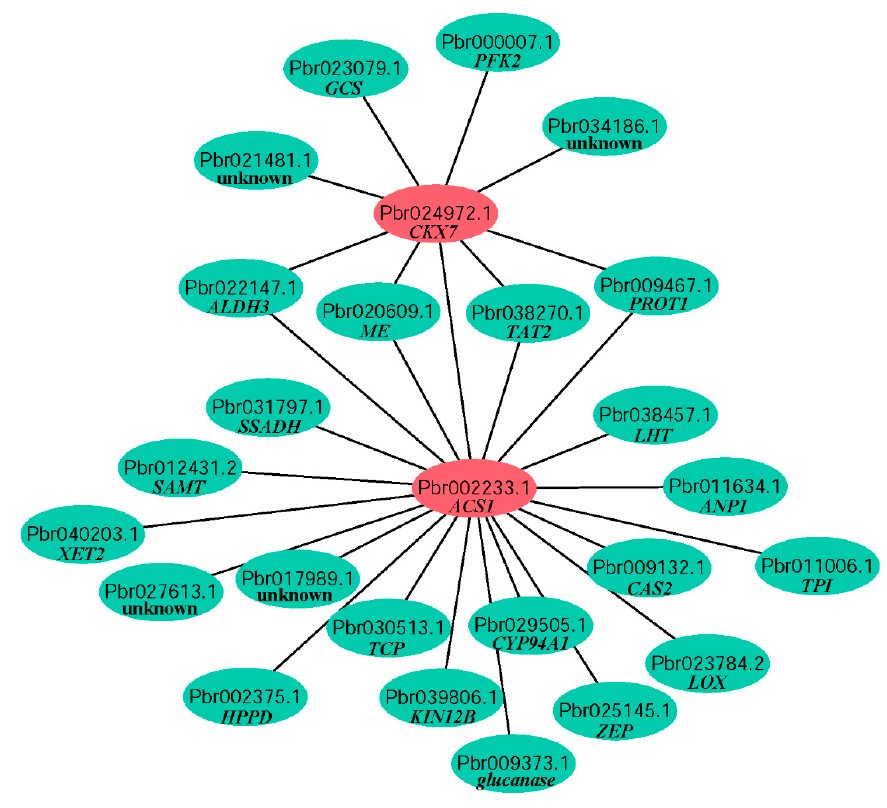
Figure 6. Protein protein interaction of CKX7 and ACS.